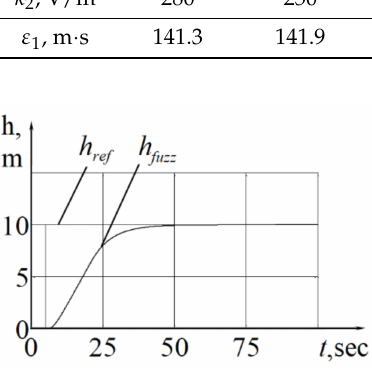
Figure 11. The transition process of stepwise changes in the depth of the AUV with PD-regulator: a graph of changes in